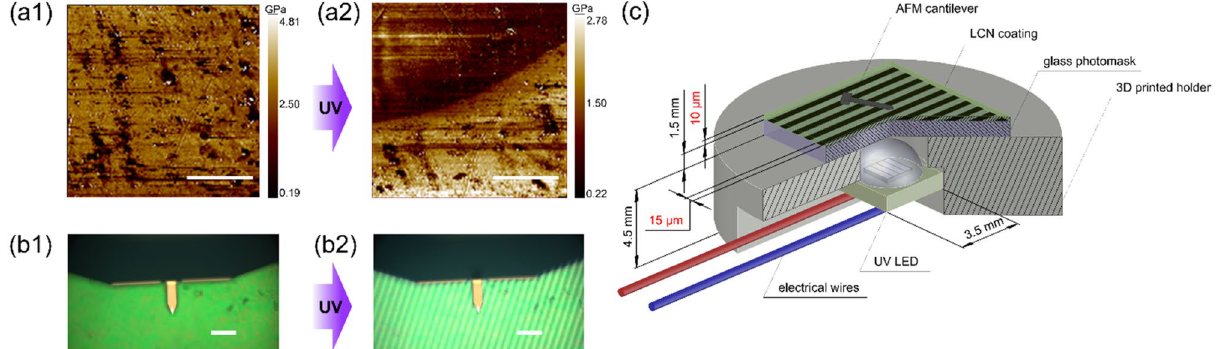
Figure 5. Modulus distribution on dye-containing LCN film before ( a1 ) and during ( a2 ) UV illumination with the photomask. Corresponding AFM camera images ( b1 and b2 ), showing the AFM cantilever and the photomask pattern, which appears under UV illumination. Schematic representation of the set-up used ( c ). Dimensions of the LCN coating and the photomask are depicted in red. Scale bars: 10 μm ( a1 and a2 ) and 100 μm ( b1 and b2